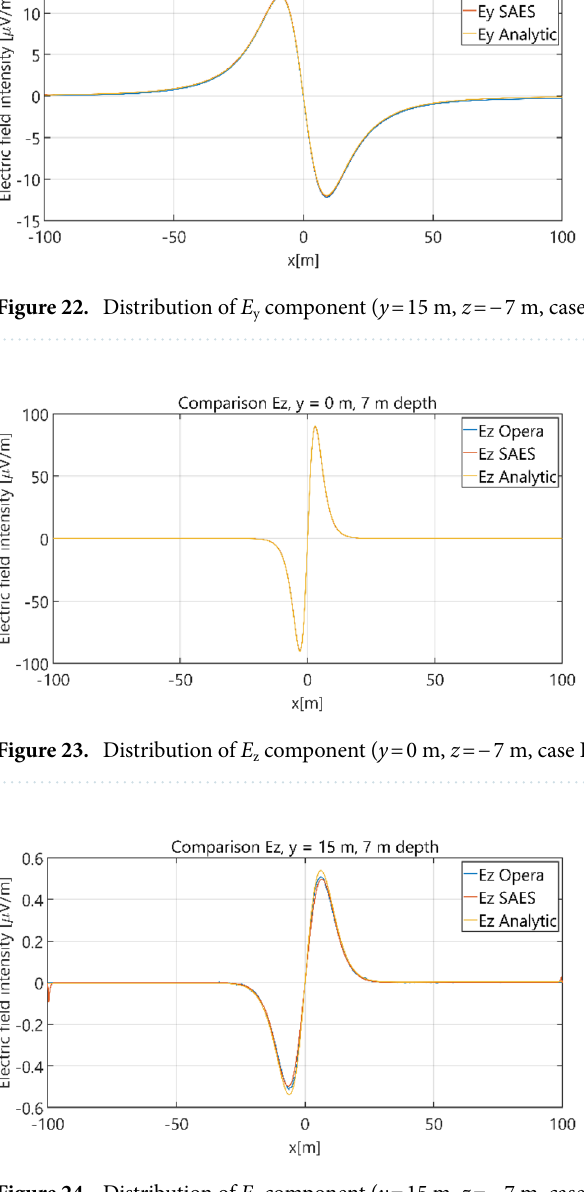
Figure 24. Distribution of E z component ( y = 15 m, z = − 7 m, case